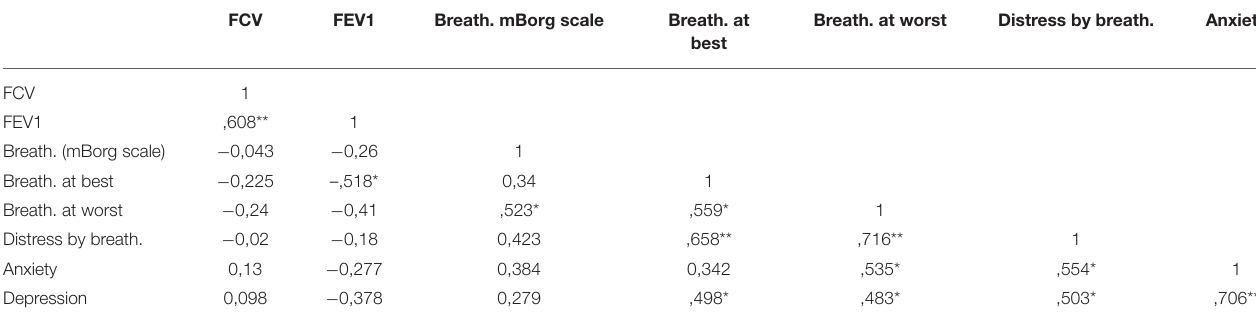
TABLE 3 | Pearsons’ linear correlations of patient’s baseline assessment. FCV FEV1 Breath. mBorg scale